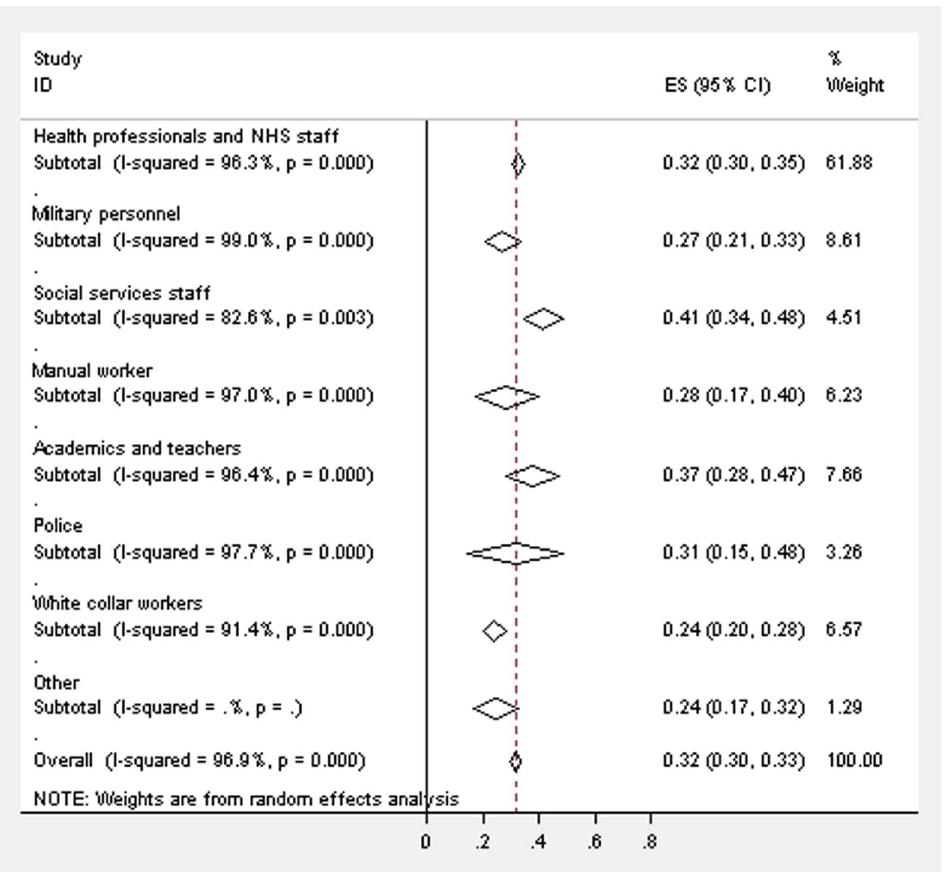
Figure 2. Forest plot displaying the weighted estimates for CMD caseness across the occupational groups.